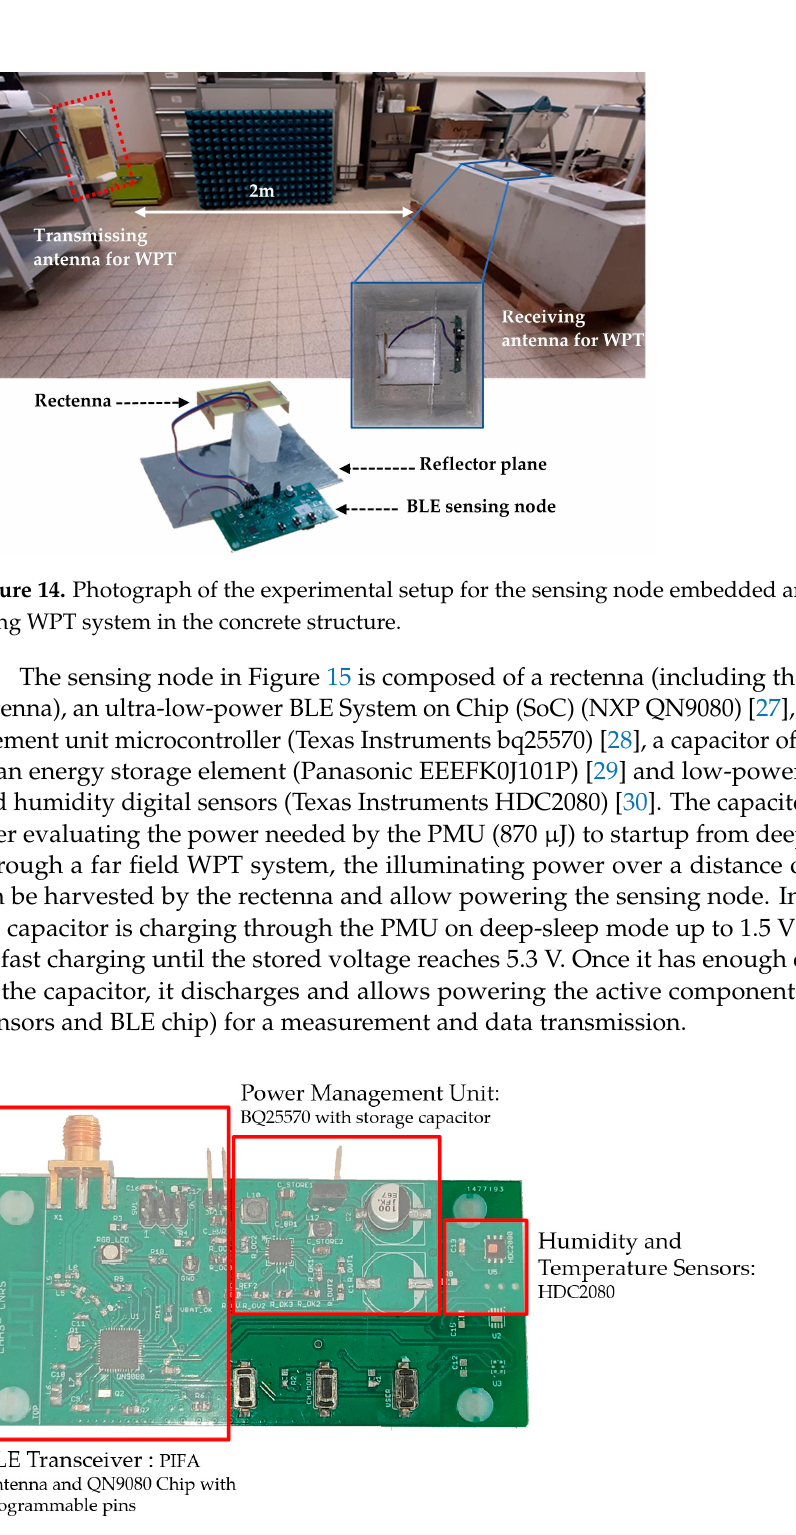
Figure 15. Developed sensing node for BLE communication.